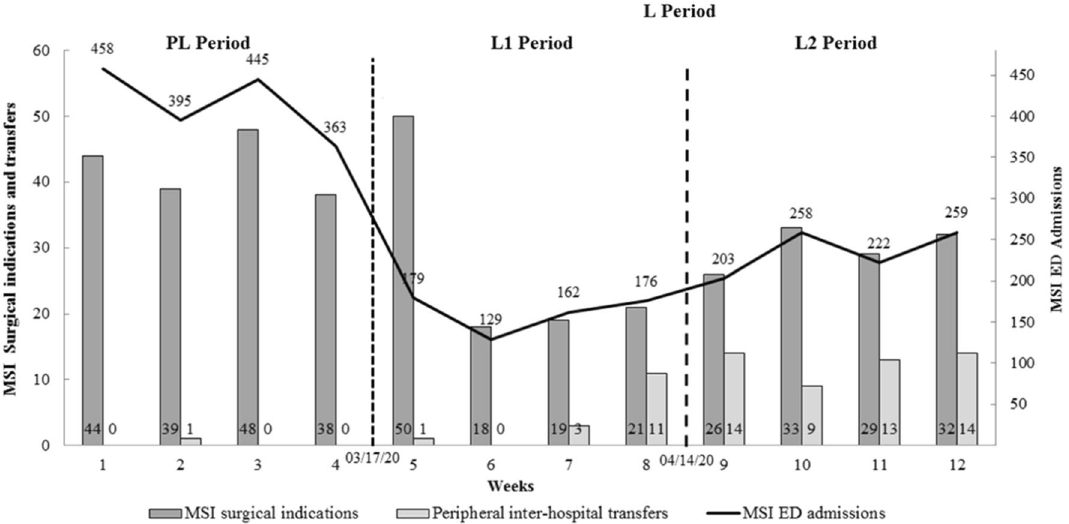
Figure 2. Change in the weekly surgical procedures, peripheral inter-hospital transfers, and weekly admissions for MSI in the ED of Nantes regional University Hospital (linear scale graph). The first vertical line refers to the national French lockdown on the 17th of March 2020. The second vertical line refers to the virtual break separating L1 (Early lockdown period) and L2 (Late lockdown period) on the 14th of April 2020. MSI: Musculoskeletal injury, ED: Emergency department, PL: Pre-lockdown (from 02/18/20 to 03/16/20), L: Lockdown (from 03/17/20 to 05/11/20), L1: Early lockdown (from 03/17/2020 to 04/13/20), L2: Late lockdown (from 04/14/20 to